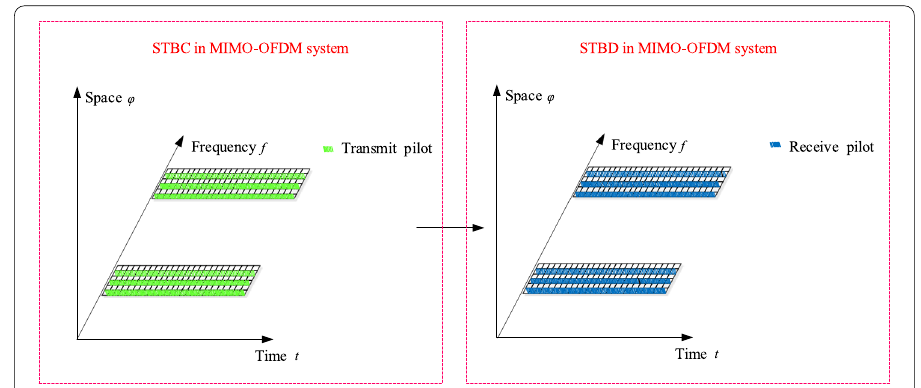
Fig. 2 Pilot allocation in time, frequency, and space in STBC and STBD of MIMO-OFDM